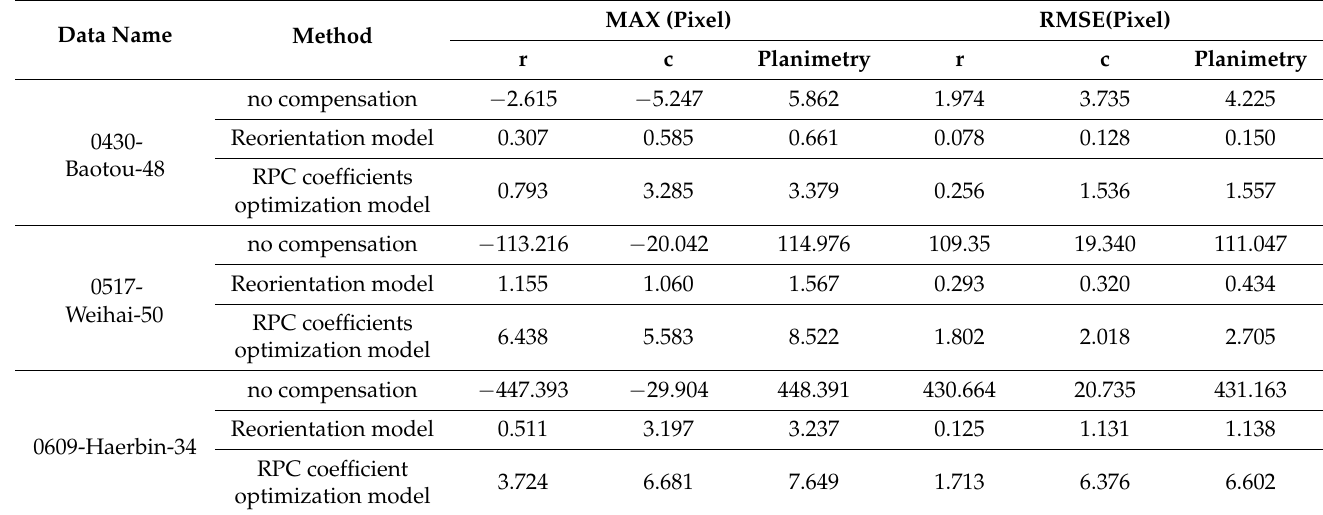
Table 5. RPC coefficient optimization precision